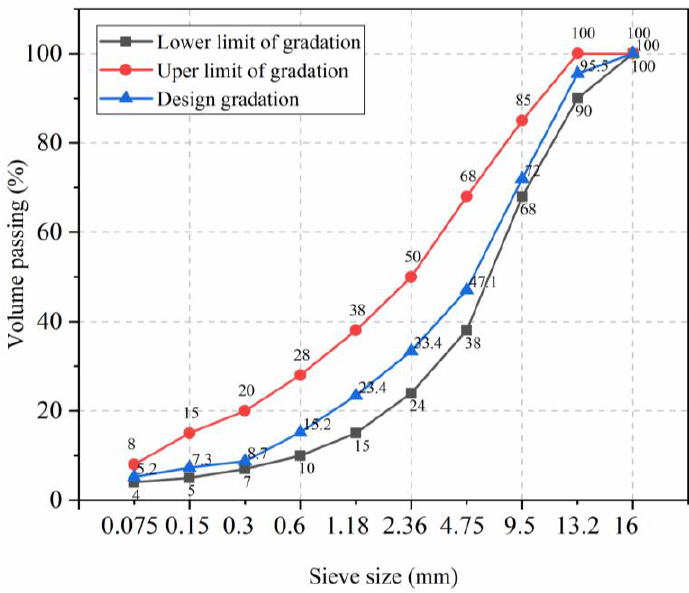
Figure 2. The Gradation Curve. The lengths of steel wool fiber are 1, 3, 5 mm, and the diameter is 70 μm. It was produced in Zhangjiagang Xinli Metal Co. LTD, Zhangjiagang, China. The density is 7.220 g/cm 3 , and tensile strength of single filament is 800 MPa. The macrographs and micrographs of steel wool fiber are shown in Figures 3 and 4 [34].